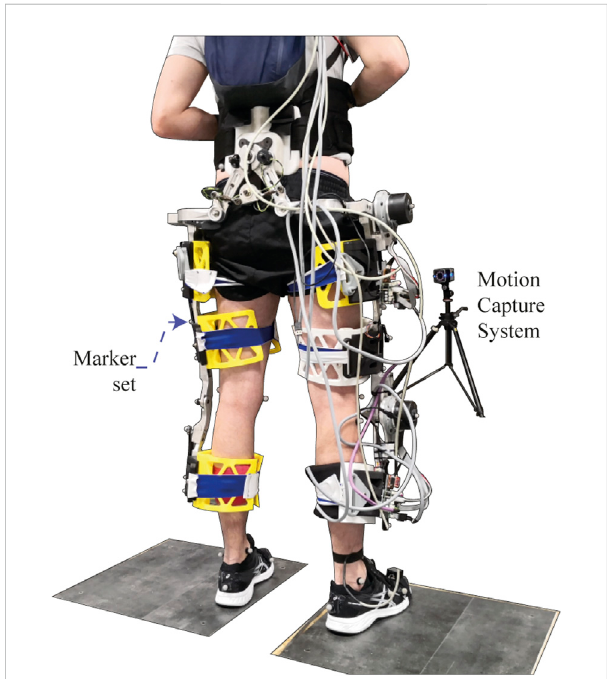
FIGURE 9 Experimental setup for trials with healthy subjects wearing the AGoRA